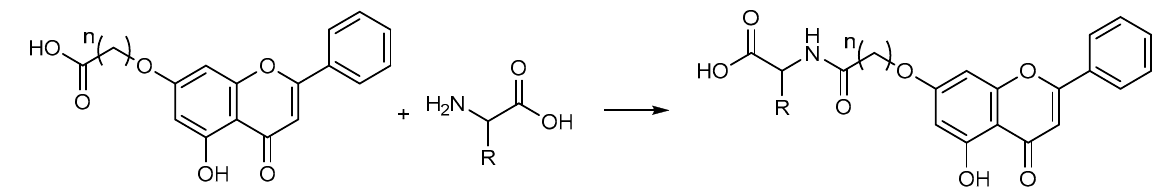
Figure 9. General scheme for synthesis of amino acid derivatives of chrysin.